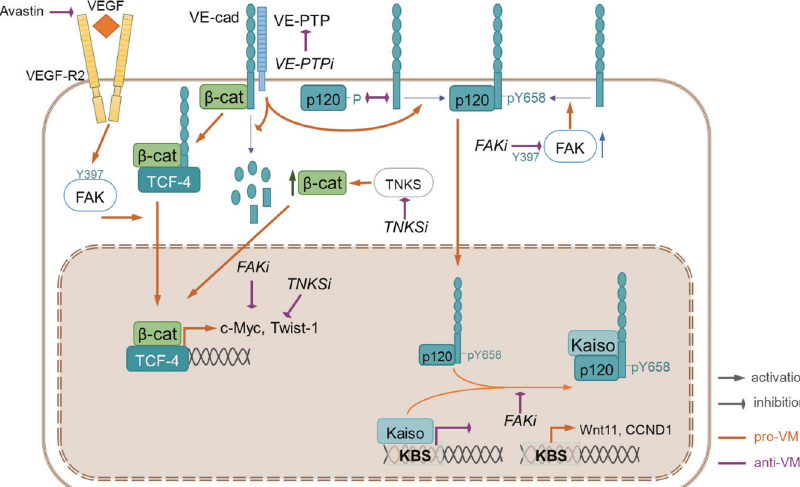
Fig. 8 Proposed model for the mechanism by which elevated Y658 of VE-Cadherin/ β -catenin/TCF-4 axis leads to increased VM in malignant melanoma cells. VM VE-Cadherin positive cells express a basal activate FAK Y397 enhance Y658 VE-Cadherin implication to different transcription factors (Kaiso, TCF-4) as well as target genes (CCDN1, Wnt11, C-Myc, Twist-1), VEGFi, FAKi, TNKSi, and VE-PTPi fi nally inhibit VM formation in cutaneous/uveal melanoma cells. Further details are explained in the “ Discussion ”